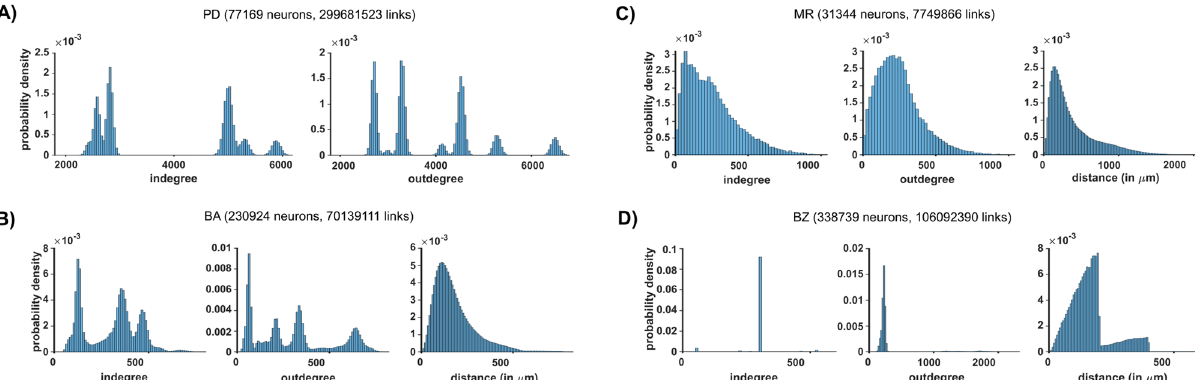
Figure 2. Degree distributions of different large-scale models and connection length distribution. ( A ) Degree distributions of a 1 mm 2 cortical column model 33 , indicated as PD; connection lengths are not available. ( B ) Degree distributions and connection length distribution of a visual cortex model 29 , indicated as BA. ( C ) Degree distributions and connection length distribution of a neocortical column model 30 . ( D ) Degree distributions and connection length distribution of a hippocampus CA1 area model 13 , indicated as